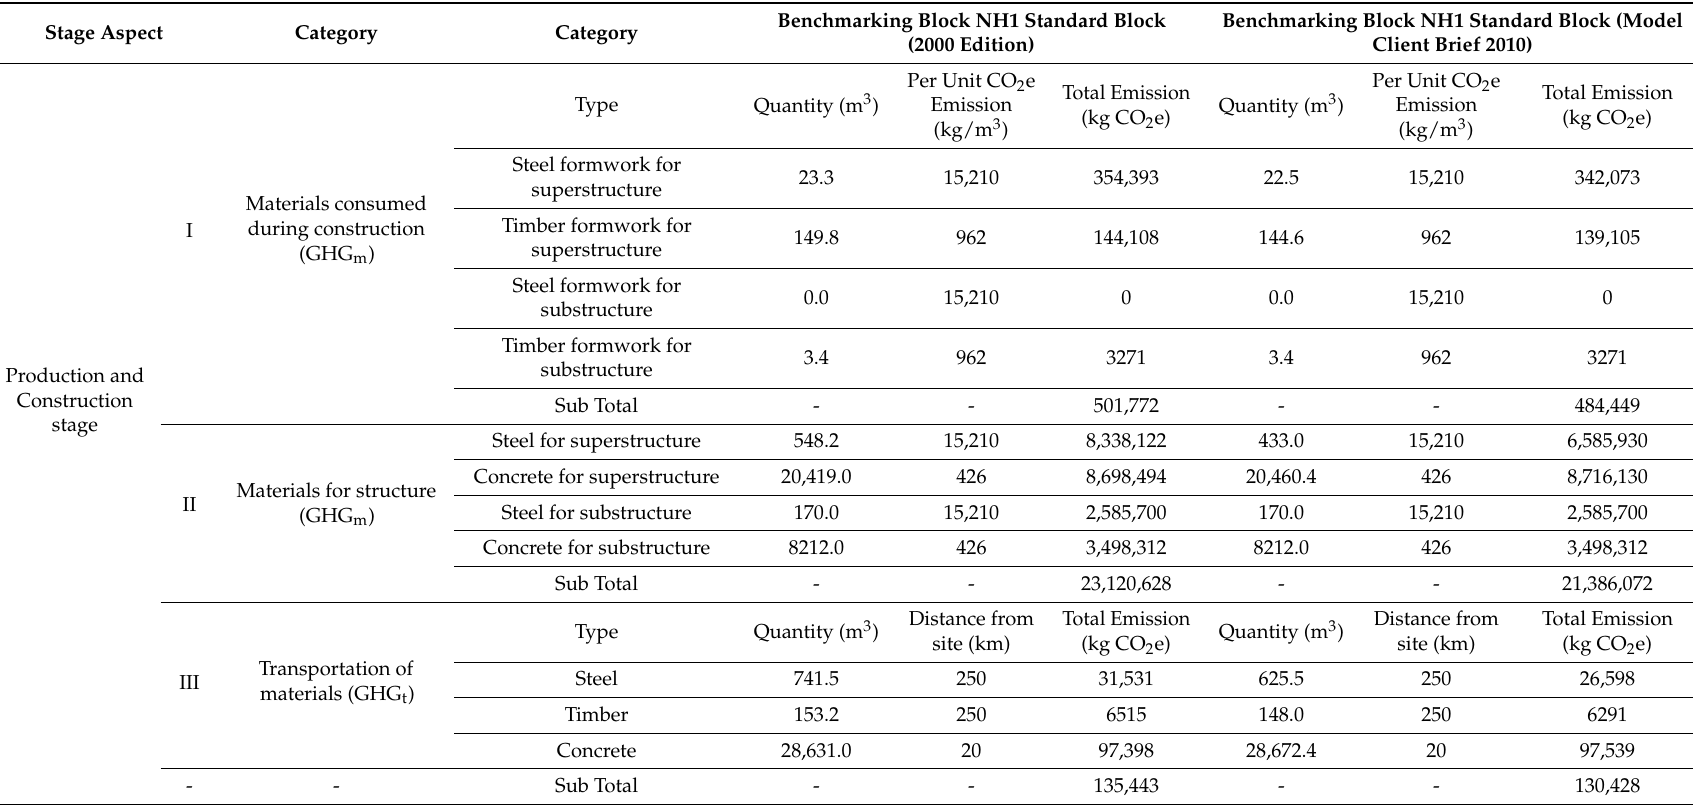
Table 4. Evaluation of GHG emissions of the studied case in Hong